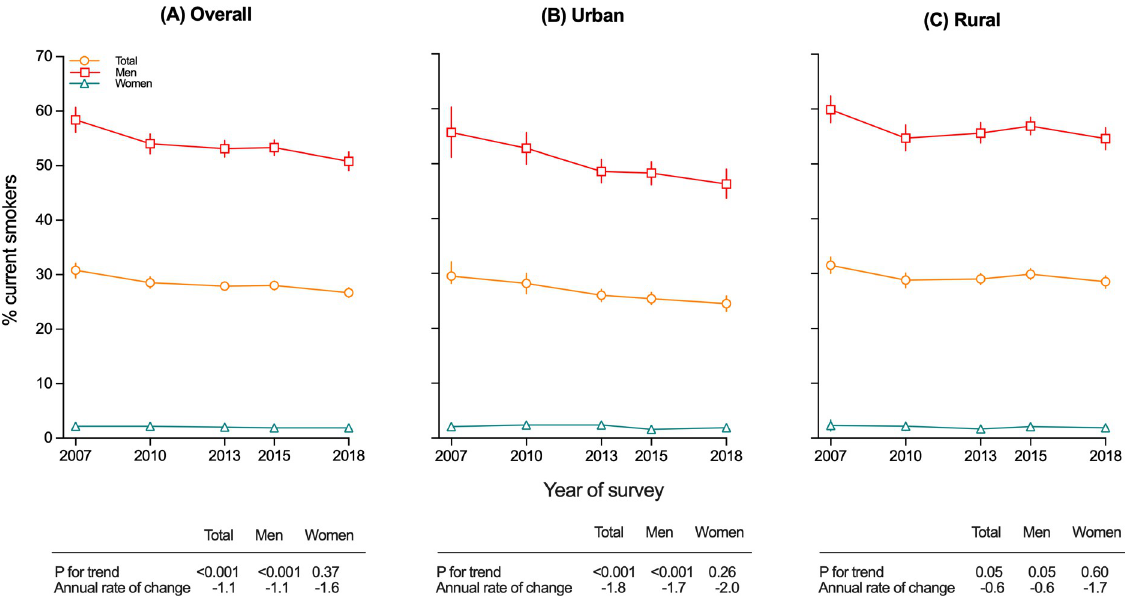
Fig 1. Trends in prevalence of current smoking from 2007 to 2018 among adults aged 18–69 years, by sex for overall (A), urban (B), and rural (C). Data from the 2007, 2010, 2013, 2015, and 2018 CCDRFS. CCDRFS, China Chronic Disease and Risk Factor Surveillance; CI: confidence